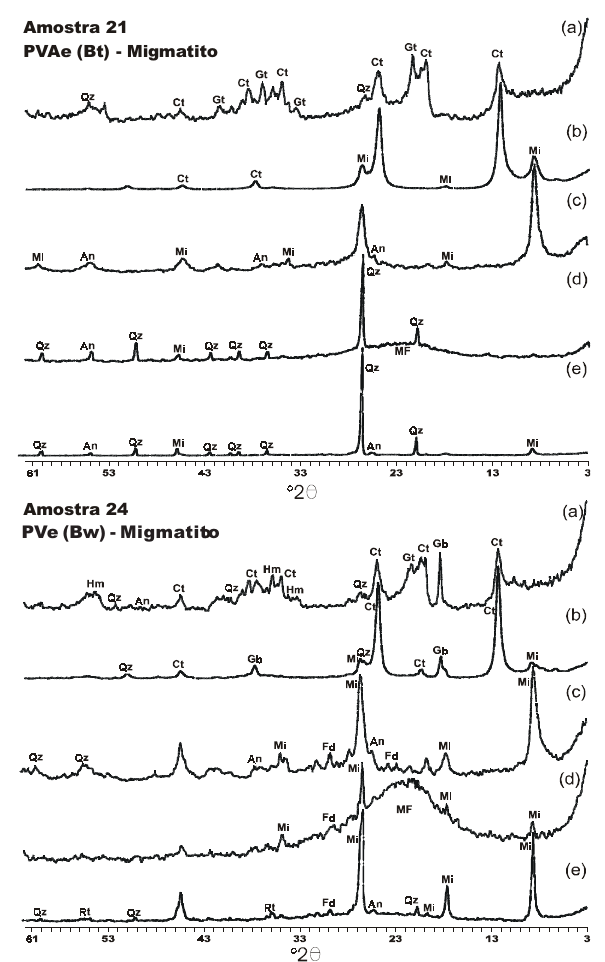
Figura 3. Difratogramas de raios-X da fração argila orientada do PVAe e do PVe do Grupo Araxá, mostrando a mineralogia com os tratamentos seqüenciais (sem tratamento (a), após DCB (b), (d) e após após NaOH 5 mol L -1 (c), após NaHSO 4 NaOH 0,5 mol L -1 (e)): An - anatásio, Ct - caulinita, Gb - gibbsita, Gt - goethita, Hm - hematita, Mi - mica, MF - material formado após NaHSO , Qz - 4